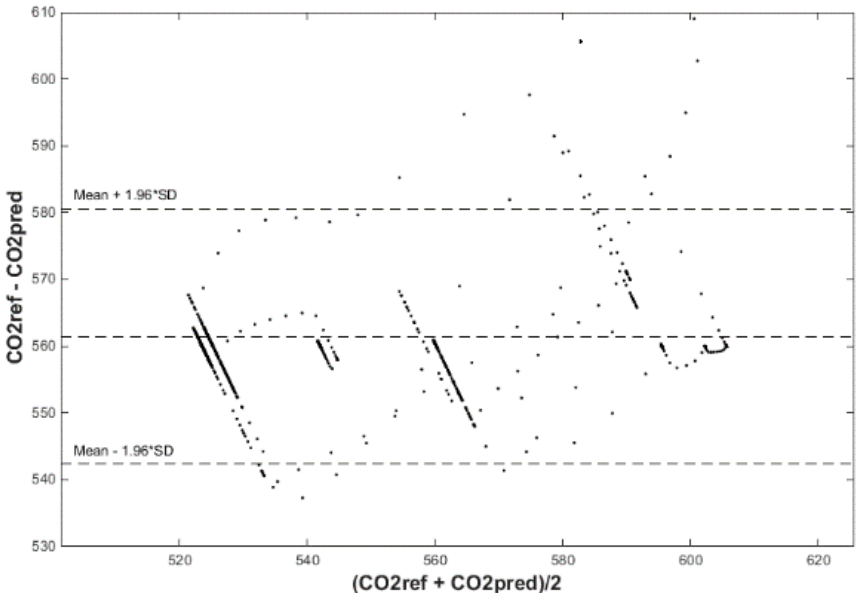
Figure 27. Bland–Altman for the reference and predicted CO 2 waveforms (SRLMS AF) from 26 June 2018 in R203 with an ANN with 60 neurons and SCG method trained with data from 25 June 2018 in R203. Table 6. Learned ANN SCG from 25 June 2018 in R203 (with T in, rH in and an FBG sensor for PPM) and prediction with cross-validation for 26 June 2018 in R204 (with T in, rH in and an FBG sensor for PPM), 27 June 2018 in R204 (with T in, rH in and an FBG sensor for PPM), 28 June 2018 in R204 (with T in, rH in and an FBG sensor for PPM).